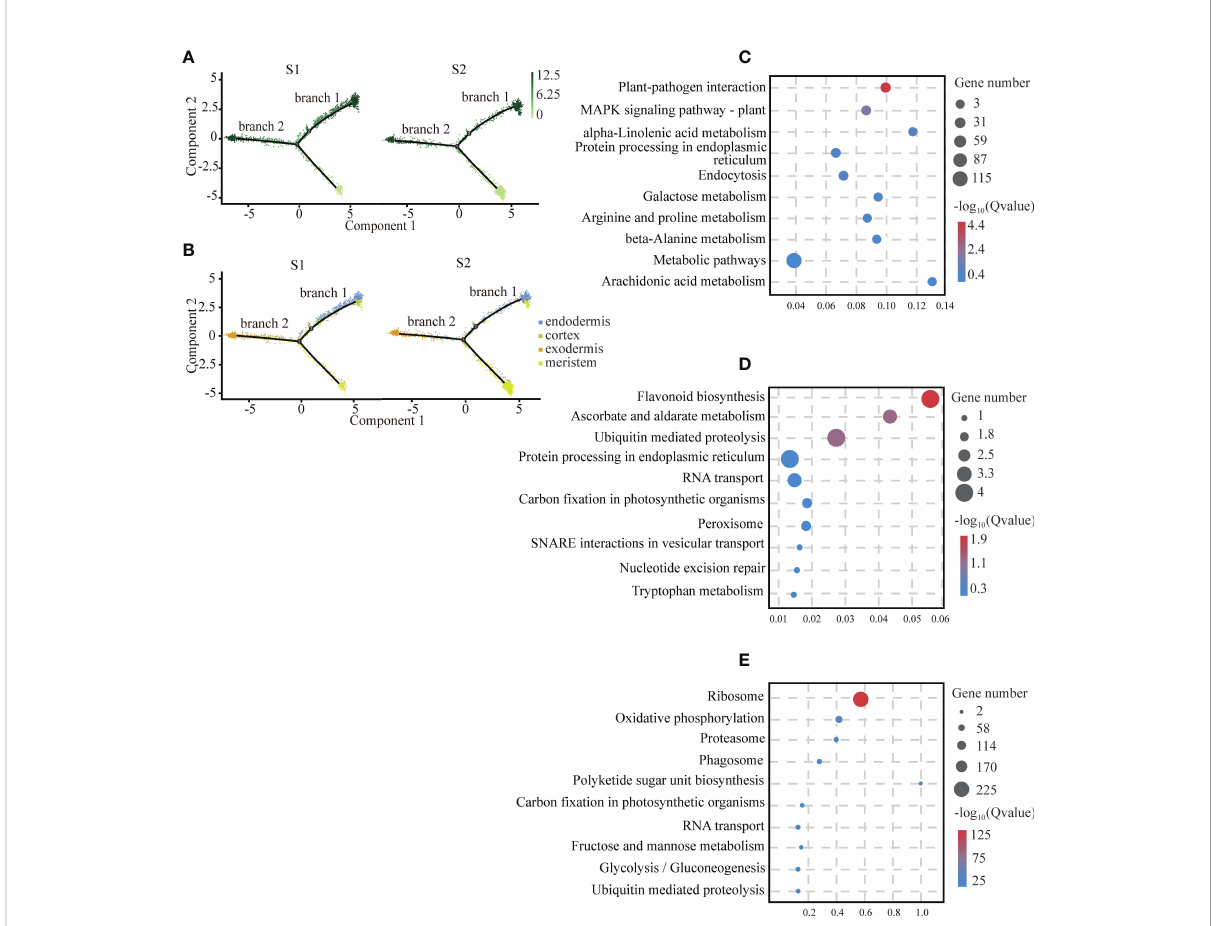
FIGURE 3 Differentiation Trajectory of Cartical Tissue. (A) Single-cell transcriptome data revealing the differentiation trajectory of cortical tissue and meristem from S1 and S2 analyzed by Monocle 2. Each dot indicates a single cell. Different color on the dots indicates the pseudotime scores. (B) Cell types labeled on the differentiation trajectory for S1 and S2, respectively. (C – E) Scatter plots of GO and KEGG enrichment analysis of up-regulated genes in exodermis (C) , endodermis (D) and meristem (E) cell types after the aggregation of S1 and